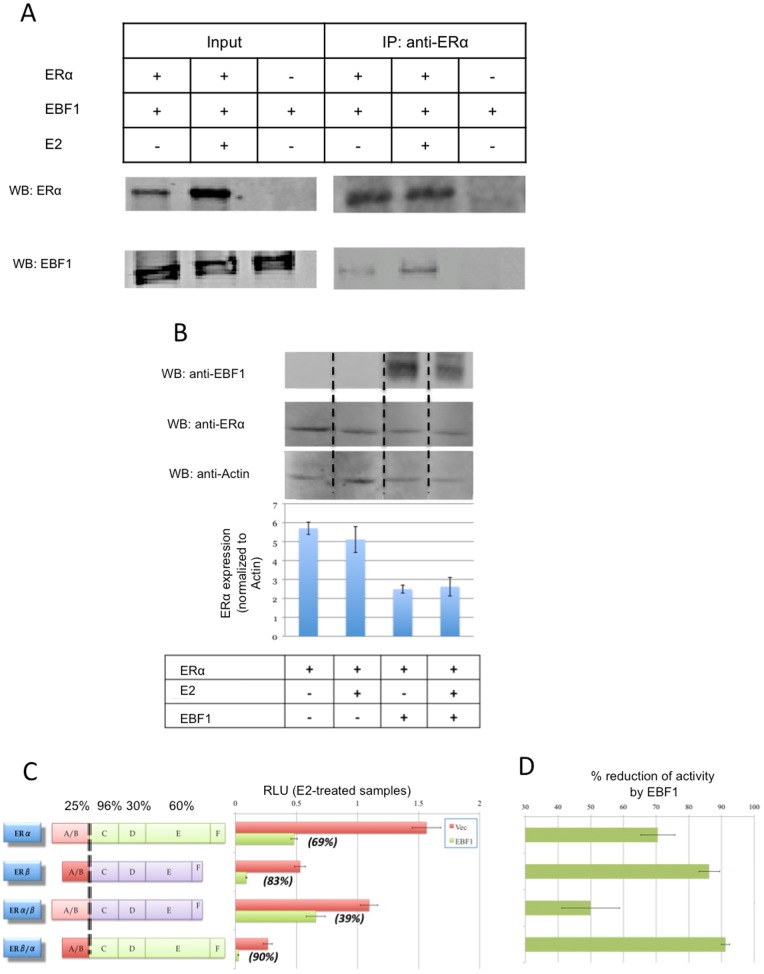
EBF1 differentially regulates ERα and ERβ.(A,B) MCF-7/C4–12 cells were transfected with ERα in the presence or absence of EBF1 and then treated with 10 nM E2 or Vehicle control. (A) Association between ERα and EBF1 was confirmed by co-immunoprecipitation assay. (B) ERα protein levels were measured on Western blots (bands from each row were from the same gel but were rearranged to fit the order similar to that shown in figure 7A on ERβ). (C) Transcriptional activities of different ER constructs were measured with the ERE-Luciferase reporter assay in the presence and absence of EBF1; percentages in parentheses represent how much EBF1 affected each construct, as measured by subtracting luciferase signal in EBF1 transfected samples from their vector controls. (D) Effect of EBF1 on ER transcriptional activities measured by subtracting the luciferase signal in EBF1 transfected samples from their vector controls; bar graph represents the average of three independent experiments; error bars represent standard deviations.